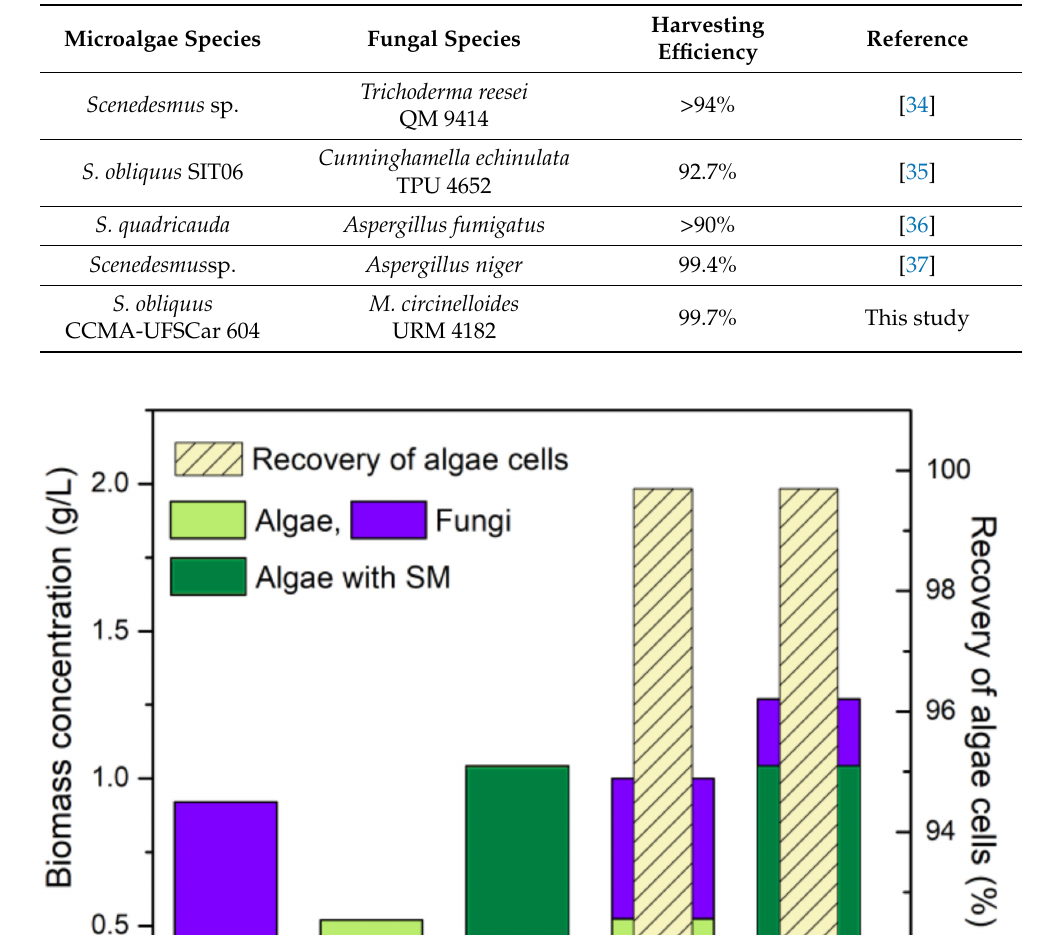
Table 3. Relative harvesting efficiencies of microalgae-fungi consortium described in the literature and the present study.